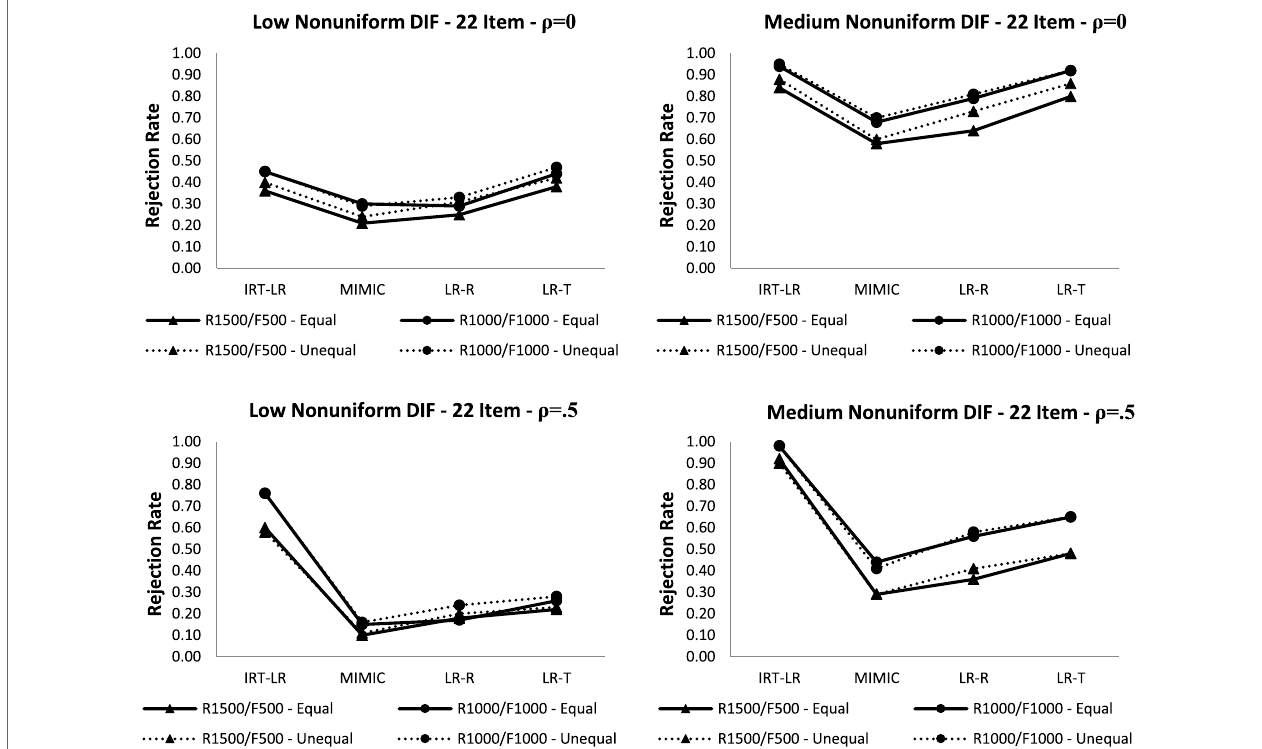
FIGURe 3 | Rejection rates for non-uniform differential item functioning (DIF) with equal and unequal latent means between focal and reference groups in the 22-item test ( note : LR-R is logistic regression with raw scores; LR-T is logistic regression with latent trait